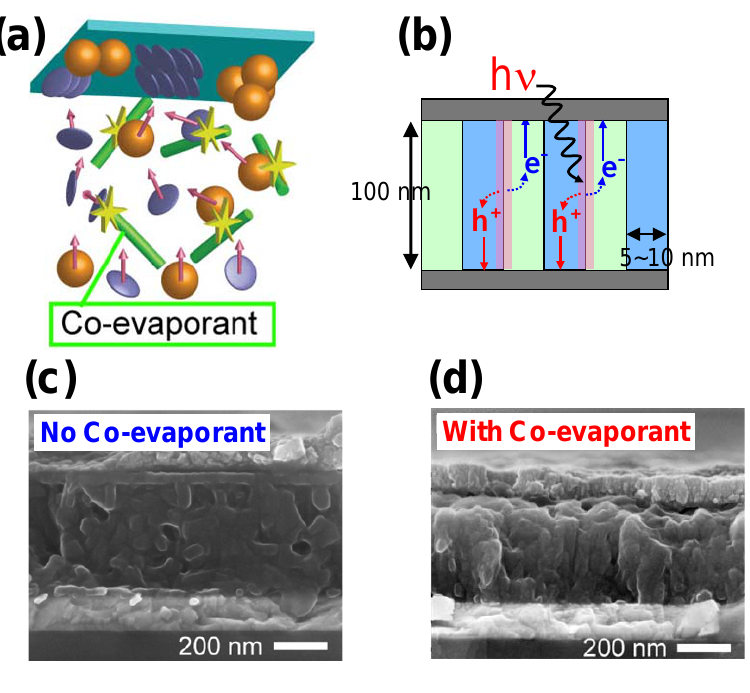
Figure 5. ( a ) Co-evaporant 3 rd molecule introduction. The balls, plates, and sticks correspond to C , H Pc, and 3 rd molecules, respectively; ( b ) Vertical superlattice structure. 60 2 Cross sectional SEM images of C :H Pc co-deposited films without ( c ) and with 60 2 ( d ) 3 rd molecule. Phase-separation and crystallization occurs by introducing co-evaporant 3 rd